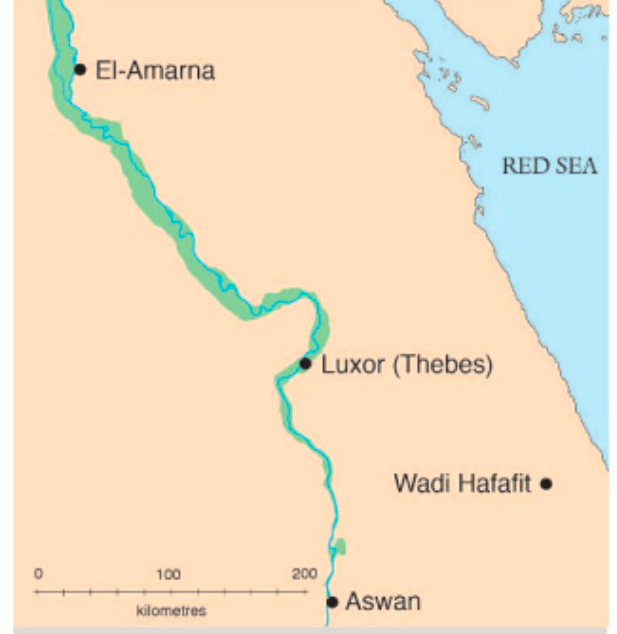
Figure 1. Location map of Hafafit area.